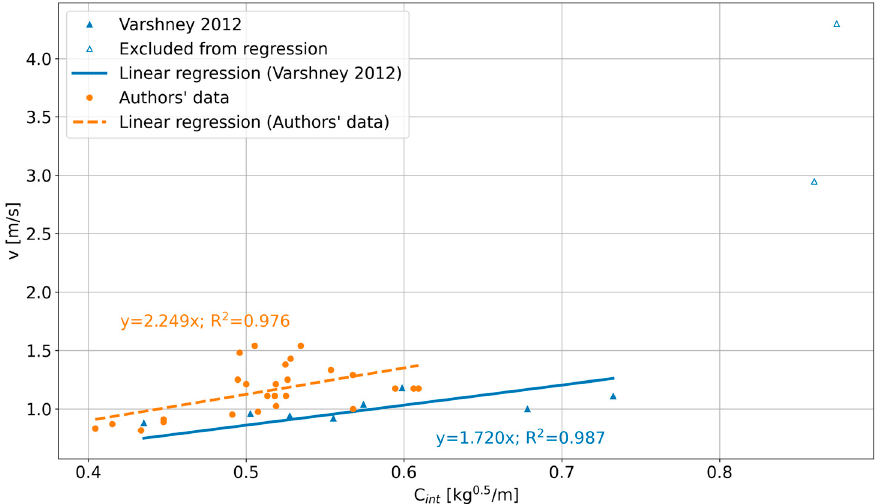
Figure 14. Sycamore seed data. Authors’ own data (orange dashed line) plotted alongside Varshney 2012 data (blue solid line). Note that the authors’ data uses average falling speed, including transition, whereas the Varshney 2012 data is for terminal velocity. Varshney 2012 data reprinted/adapted with permission from Ref. [13]. © IOP Publishing Ltd. and London Mathematical Society 2011. Reproduced with permission. All rights reserved.